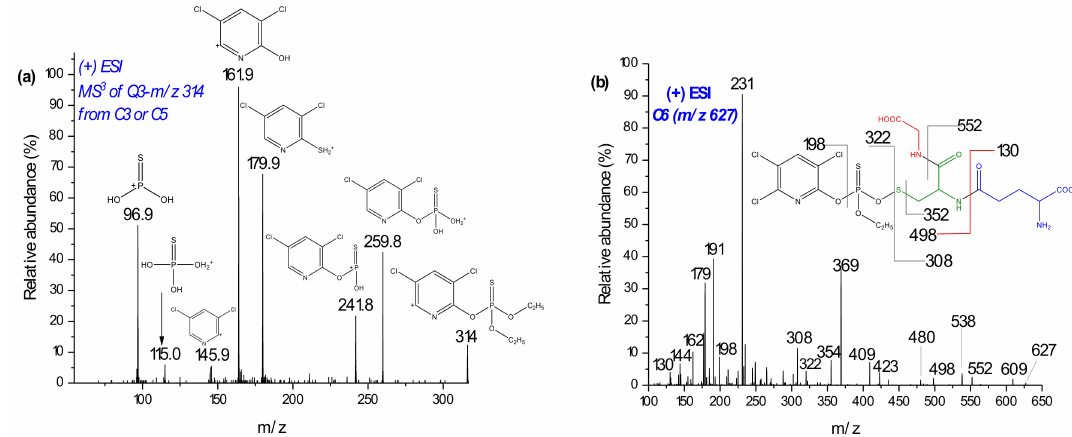
Figure 3. Mass spectra of product ion m / z 314 from C3 in MS 3 ( a ) and C6 with its suggested fragmentation measured in MS 2 ( b ) using LC-QTRAP